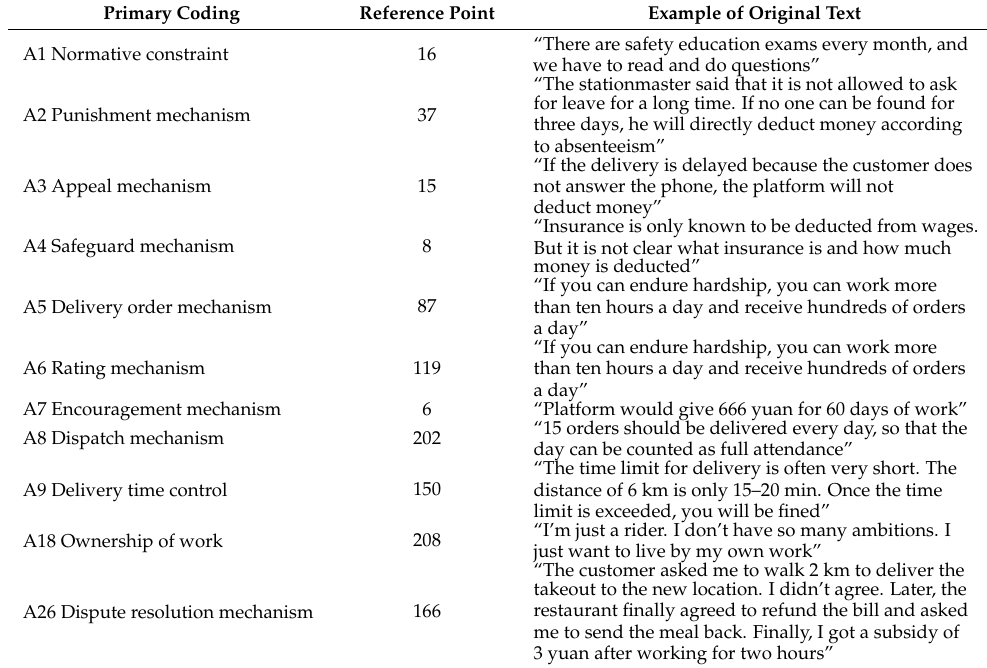
Table 4. Open coding for interview